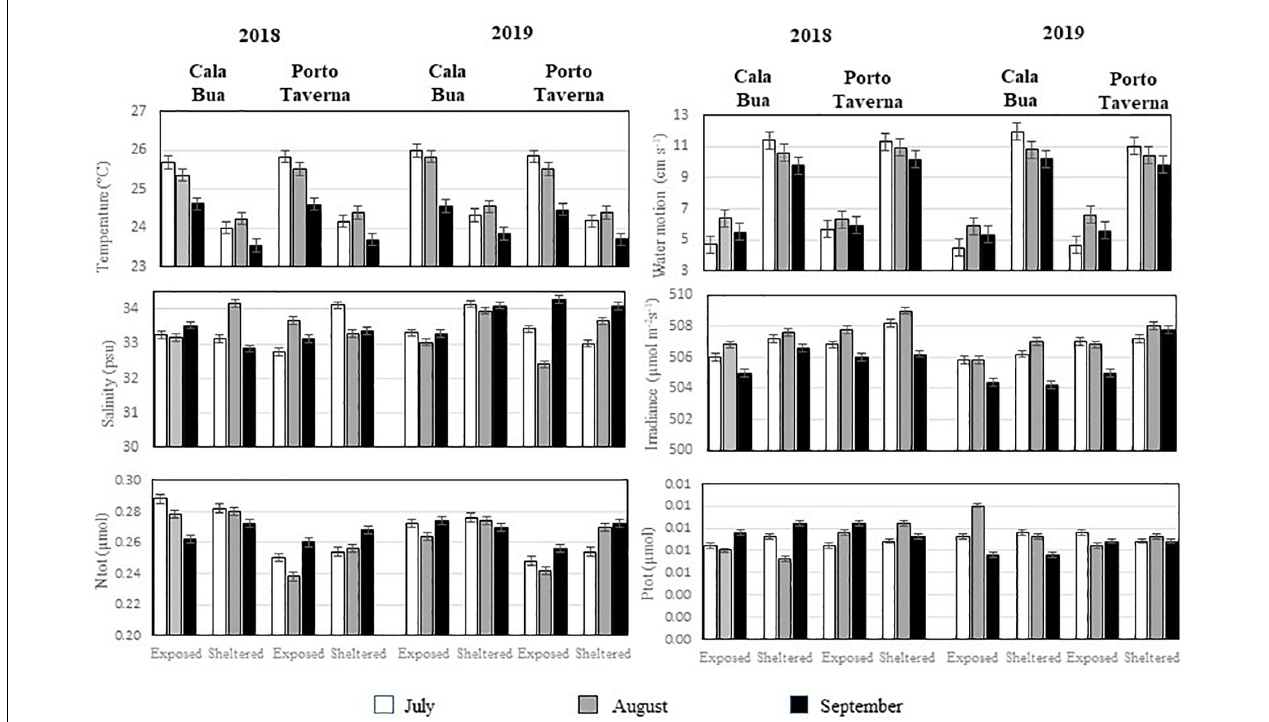
FIGURE 4 | Mean ( ± ES) value for each of the considered environmental factors (seawater temperature, salinity, water motion, light availability, and N and P concentrations) for each of the two areas in the two study sites, during each of the three periods considered for each study year.